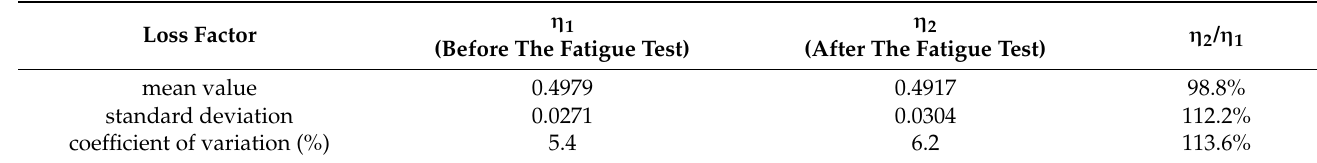
Table 7. Experimental results of the loss factor η for Mat A.